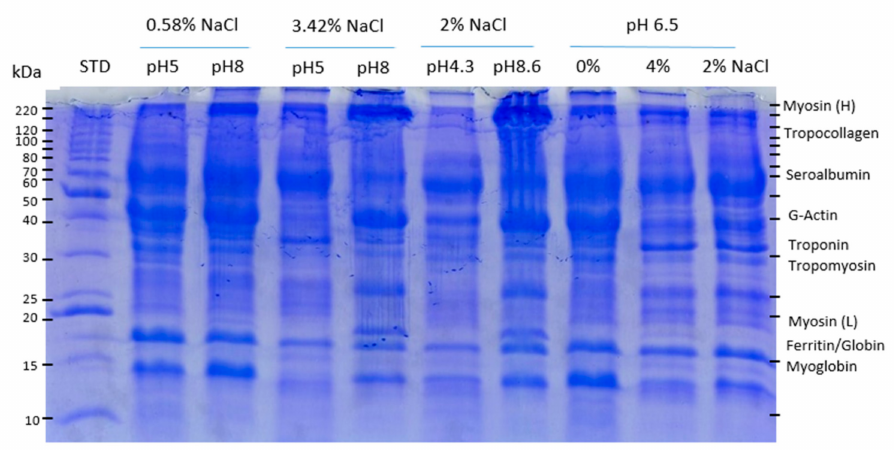
Figure 1. SDS-PAGE (12.5% PA) patterns of soluble proteins extracted from porcine heart as a function of pH and salt concentration of the extraction bu ff er. STD: molecular weight standard from 10 to 200